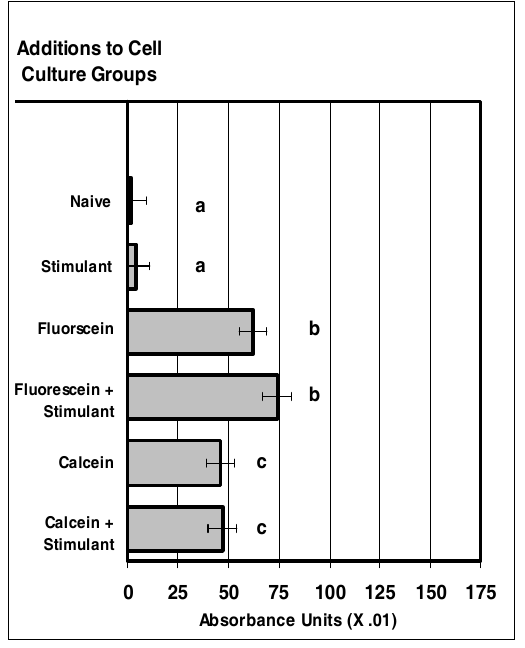
Figure 1: VIS micro-sensor dyes are internalized neutrophils. Neutrophil cultures were treated with either vehicle or visible-spectra micro-sensor dyes (fluorescein or calcein; 20 µg/10 6 cells) and incubated for 24 hours. After this incubation period, neutrophil cultures were stimulated with LPS for 24 hours. After the 24-hour stimulation period, neutrophil cultures were analyzed for VIS micro-sensor dye uptake. Spectral absorptivity was used as the endpoint for indicating cellular uptake. Percent values are expressed as the mean + SEM, N =